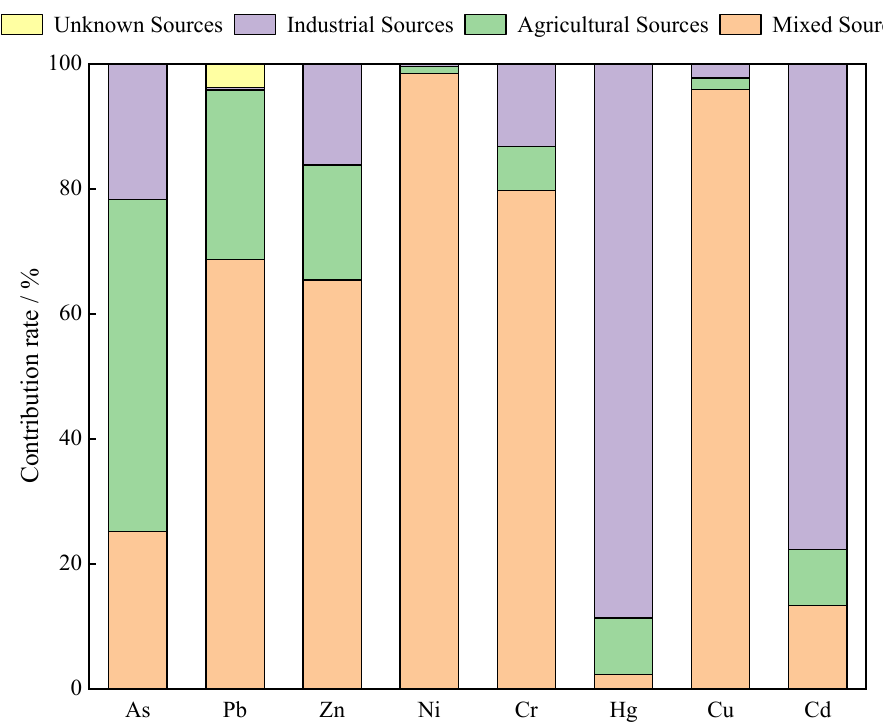
Figure 8. The contribution rate of heavy metal pollution in sediments of Weihe River Basin.